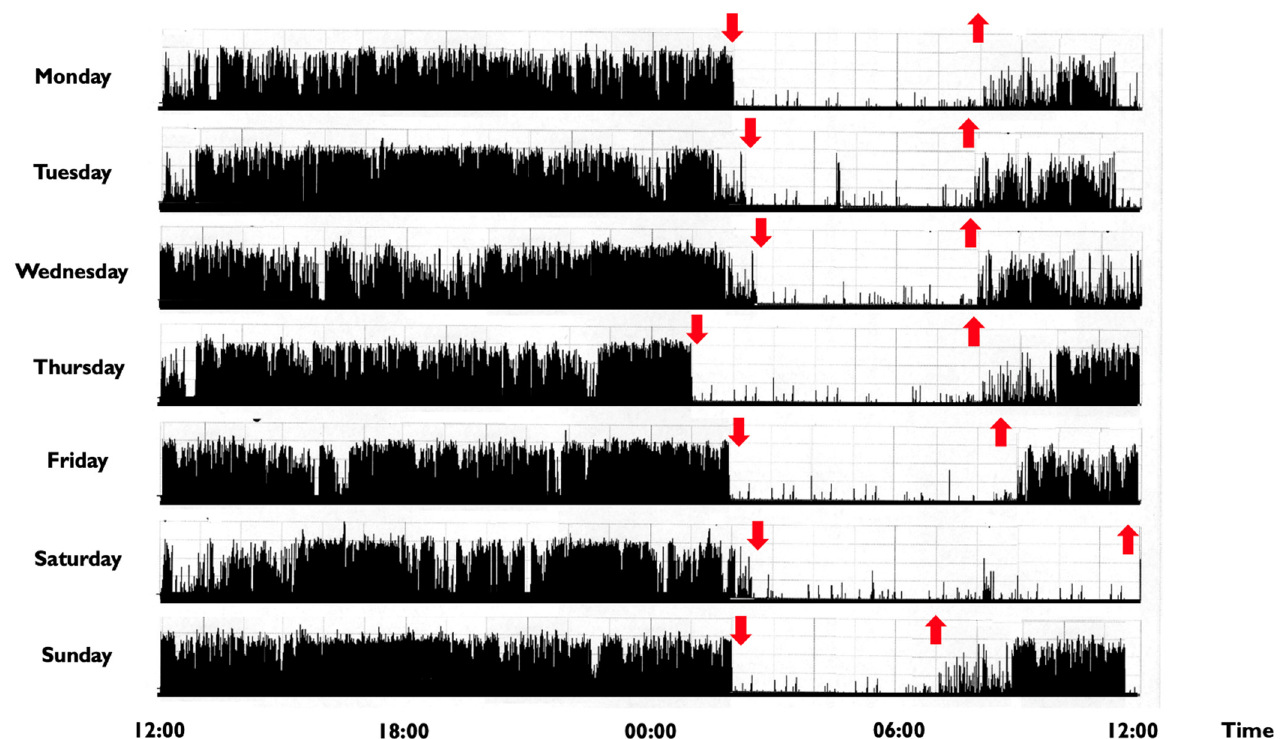
Figure 2. Representative rest activity cycles recorded in a 9-year-old boy with a delayed sleep phase disorder. Note: The actigraphic recording shows a delayed sleep-wake phase disorder with sleep onset times at around 1:30–2:00 a.m. and wake times at 8:00 during the week and at noon during weekends (the black bars indicate wake activity levels recorded at the non-dominant wrist). Downward red arrows indicate the sleep onset, while upward red arrows indicate the awakening. The actigraph model used is Micro MotionloggerWatch (Ambulatory Monitoring, Inc., Ardsley, NY, USA).